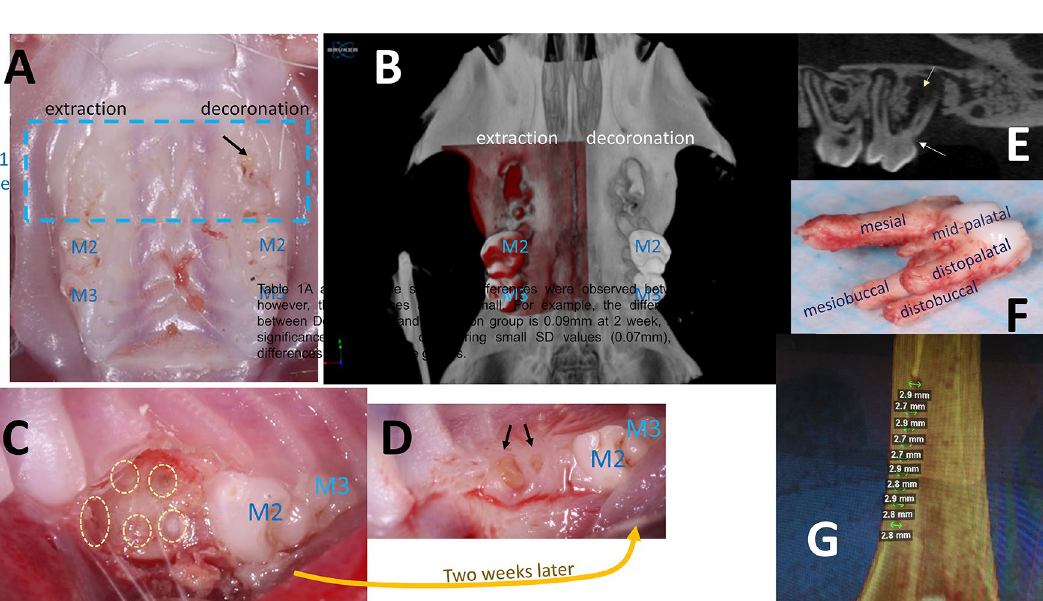
Figure 4. Micro-computed tomography (micro-CT) and histo-morphological evaluation of alveolar ridge bone preservation in standardized critical dimension socket defect model. The effectiveness of alveolar ridge bone preservation at maxillary first molar (M1) examined by micro-computed tomography (micro-CT) after creating large alveolar defect 2 weeks after decoronation and grafted with Bio-Oss Collagen. ( A ) Representative images show the coronal (top) and transaxial (middle) sections in the middle part of M1 site and the 3D occlusal view (bottom) after Bio-Oss Collagen grafting for 4th, 8th, and 12th weeks. Please note that residual grafting material at the defect site was still evident after 12 weeks. ( B ) Analyses of bone heights, middle maximum bone width, and bone volume at different time points. Graft heights were measured in the middle section of M1 site on the grafted side only. Bone volume was measured on the grafted side by adding up consecutive bone surfaces excluding the graft material on the transaxial sections mesio-distally throughout the M1 site. ( C ) Representative histological sections of the maxillary first molar (M1) to third molar (M3) region of rats after M1 decoronation, roots extraction and grafting with Bio-Oss Collagen by hematoxylin & eosin (H&E) and Goldner’s Trichrome staining at 4th, 8th, and 12th weeks. At 12th week after grafting, the defects grafted with Bio-Oss Collagen showed some bone regeneration in the defect site; however, the rate of new bone regeneration or mineralization of new bone were still not satisfactory at 12th week. Goldner’s trichrome staining shows immature bone formation and soft tissue invasion were observed but no angiogenesis found.